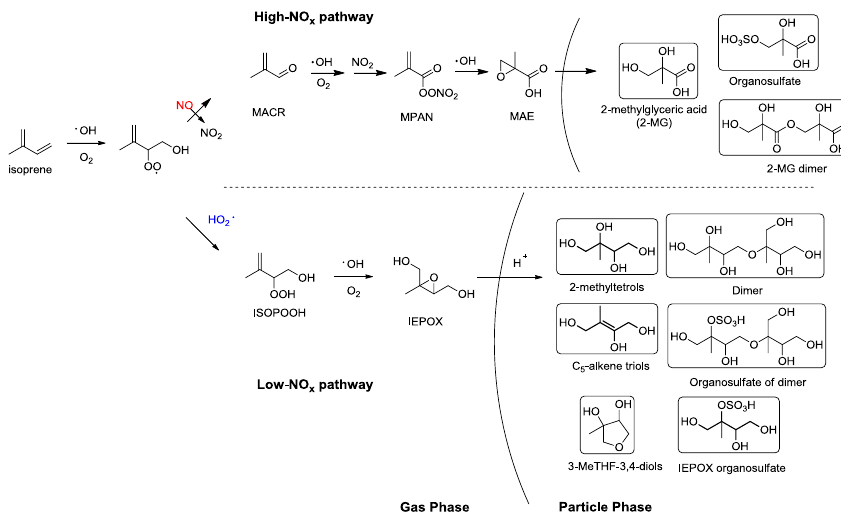
Fig. 1. Proposed chemistry leading to isoprene SOA: NO x -dependent pathways (Surratt et al., 2010; Lin et al., 2013). For simplicity, only the cis- β -IEPOX isomer is shown for IEPOX in the low-NO x (or NO-limited) pathway.